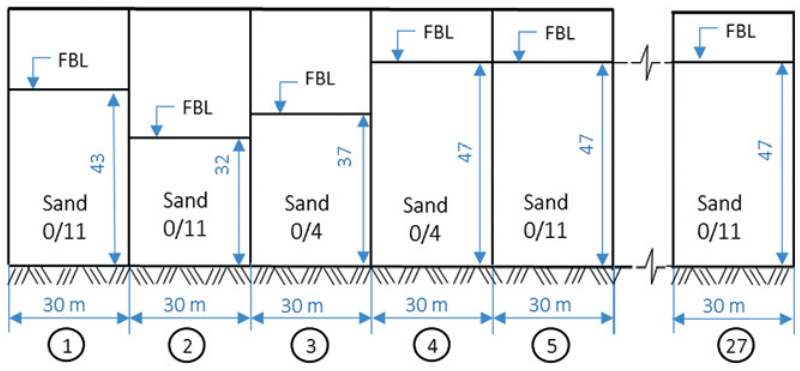
Figure 3. A fragment of the construction scheme of the Pilot Road